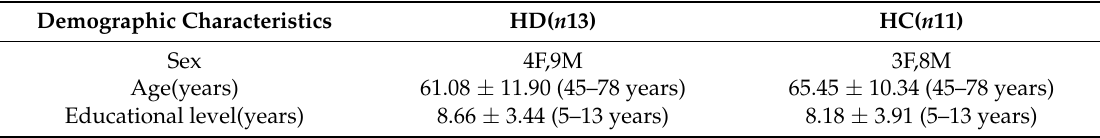
Table 1. Demographic characteristics of patients and controls.